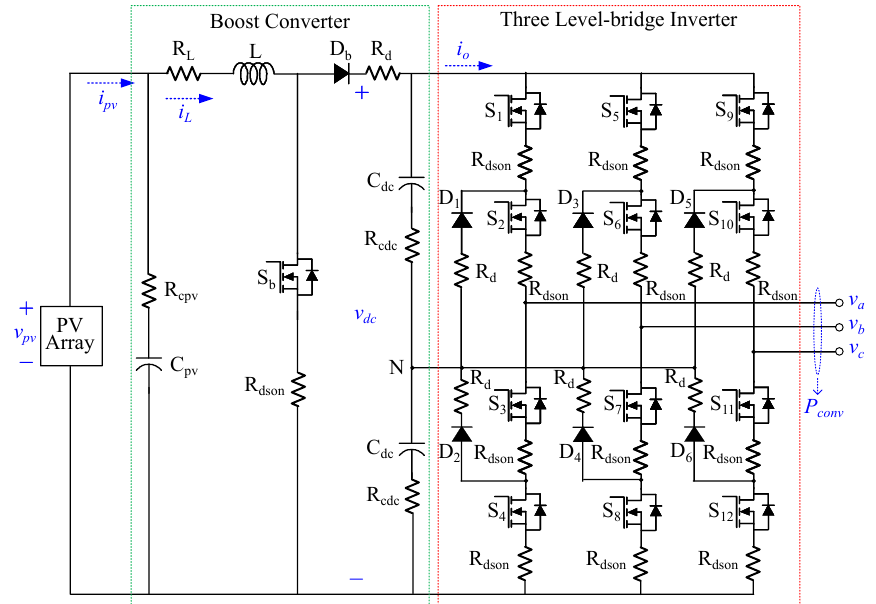
Figure 11. Topology of two-stage converter with ESR. Switch